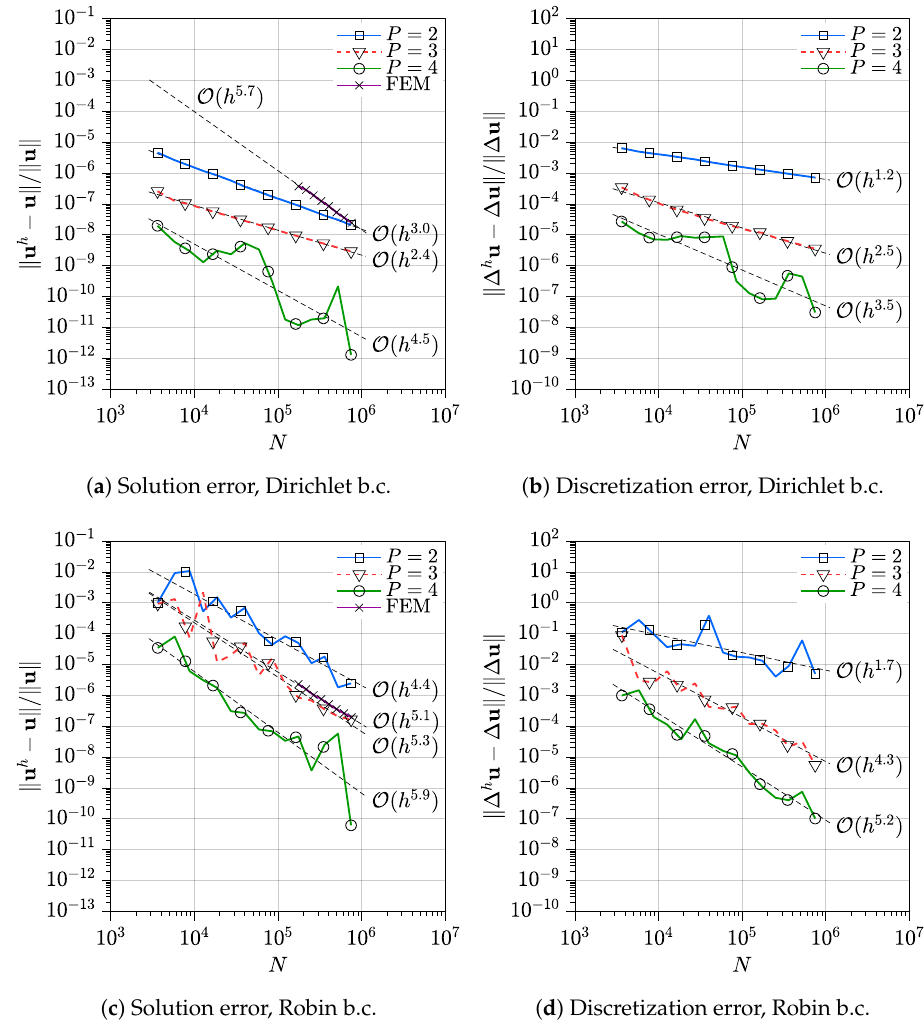
Figure 8. Convergence curves for solution and Laplace operator (or discretization error) for Dirichlet and Robin b.c., Ω :